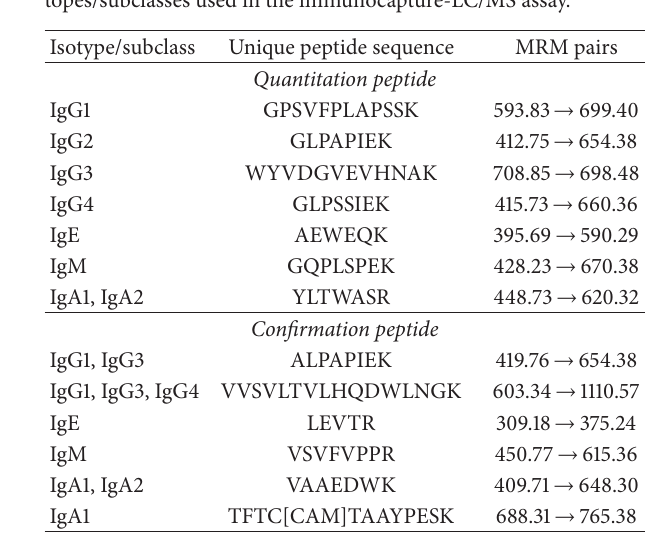
the beads and then separated from matrix using a magnet.